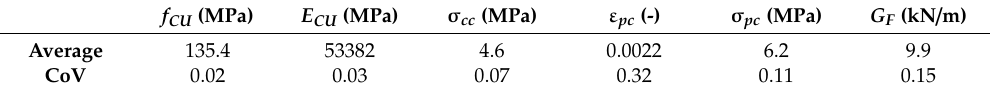
Figure 3. Flexural-tensile tests of high-performance fiber-reinforced concrete (HPFRC) prisms: ( a ) un-notched specimens, 4-point bending; ( b ) notched specimens, 3-point bending. Table 1. Material properties of the strengthening